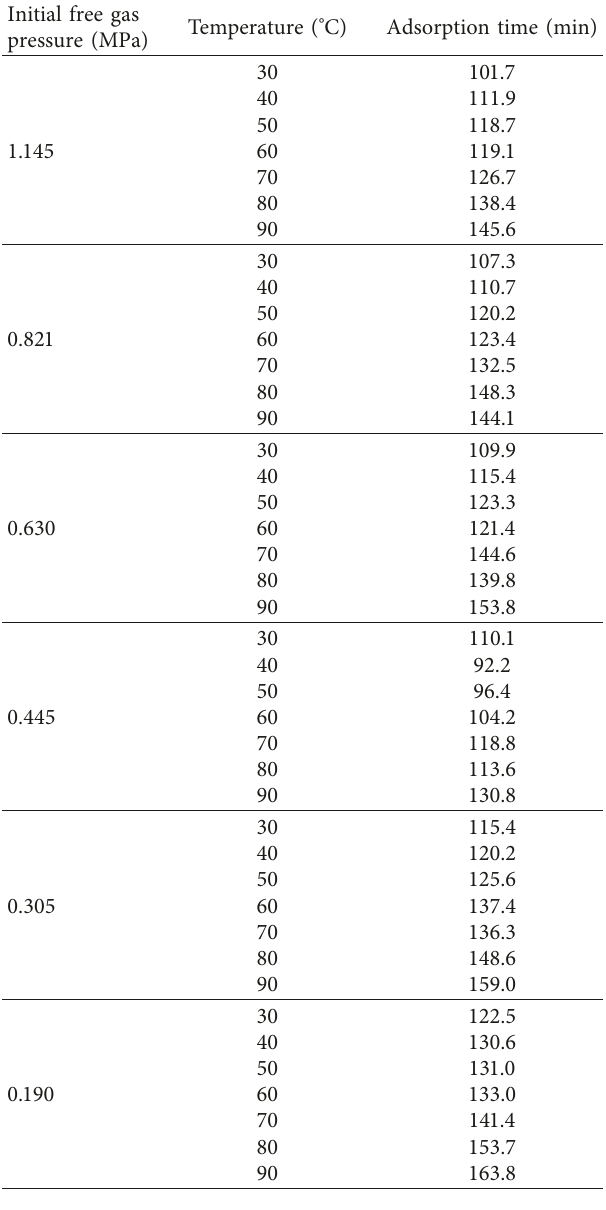
Table 4: Adsorption time of #1 coal